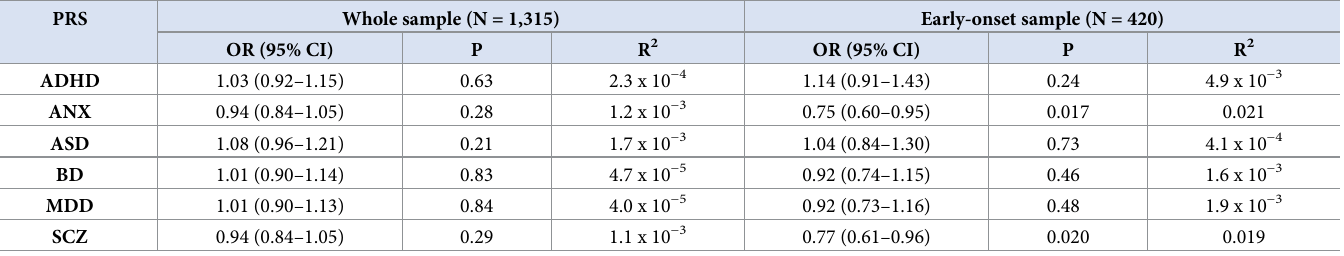
Table 2. Association of polygenic risk scores for ADHD (primary analysis) and other psychiatric disorders (exploratory analysis) with sex of individuals with anxi- ety and depression in a) the whole NCMH sample and b) the sub-group of NCMH individuals with early age at onset.